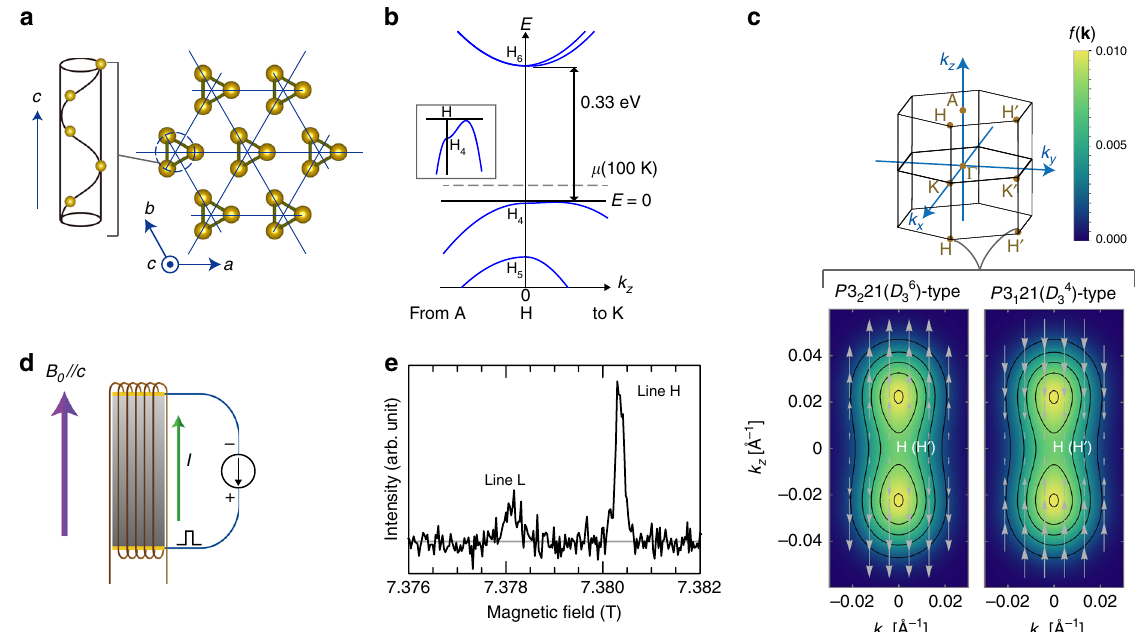
Fig. 1 Basic properties of trigonal tellurium and experimental setup. a The crystal structure of the trigonal tellurium with the right-handed structure ( P 3 1 21( D 3 4 )) consists of threefold-symmetric helical chains. b Schematic band structure of trigonal tellurium around the H and H ’ points in the fi rst Brillion zone. The two points are related by a time reversal operation. The chemical potential at 100 K is described by the broken line μ ( T = 100 K). Inset: zoom on the top of the uppermost valence band. c The fi rst Brillion zone and distribution of the holes at 100 K. Although the holes are not Fermi-degenerate at 100 K, they only belong to the uppermost valence band. The colours of the lower panels represent the distribution function of the holes at T = 100 K, f ( k ) = 1/[exp{( − E ( k ) + μ (100 K))/ k T } + 1] (where k f ( k ) contours: f ( k ) = 0.002, 0.004, 0.006, B B is the Boltzmann constant) and the lines indicate constant 0.008 and 0.01. The arrows represent the direction and the magnitude of the spin of the electron of the uppermost valence band, q ffiffiffiffiffiffiffiffiffiffiffiffiffiffiffiffiffiffiffiffiffi Þ . The spins are almost parallel to the c axis and radial-like from the H (H ’ ) point. d Geometry of the experiment. A S 2 k 2 þ Δ 2 s ð k Þ ¼ ð(cid:2) 0 ; (cid:2) 0 ; 3 Sk z = 2 z coil for NMR measurements was wound around a single crystal of tellurium. A static magnetic fi eld B 0 and a pulsed electric current I were applied parallel to the c axis. e 125 Te-NMR spectrum of a single crystal of trigonal tellurium at 100 K under a magnetic fi eld applied approximately parallel to the c axis, in the absence of a pulsed electric current. The spectrum is plotted as a function of the effective magnetic fi eld felt by the 125 Te nuclei (see